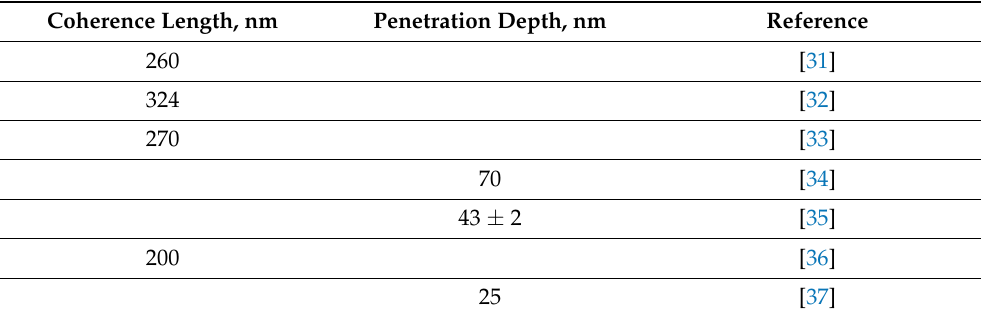
Figure A1. Experimental measurement of the critical field in bulk In as a function of temperature [30]. Table A1. Values of the coherence length and the penetration depth measured in bulk